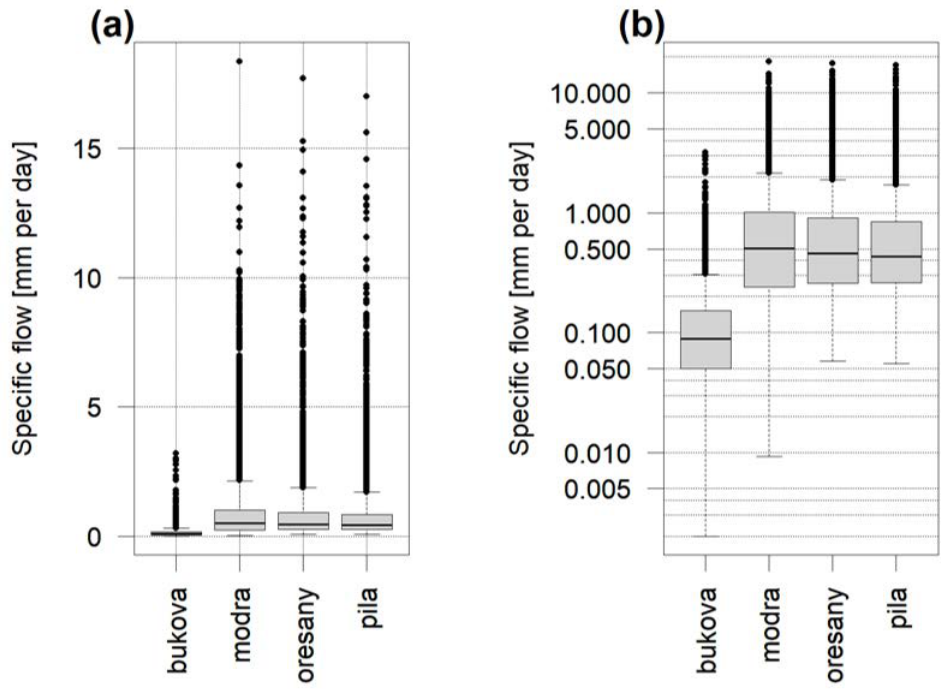
Figure 12. Box plots of the specific flows (in mm/day). ( a ) y -axis has normal scale, ( b ) y -axis has logarithmic